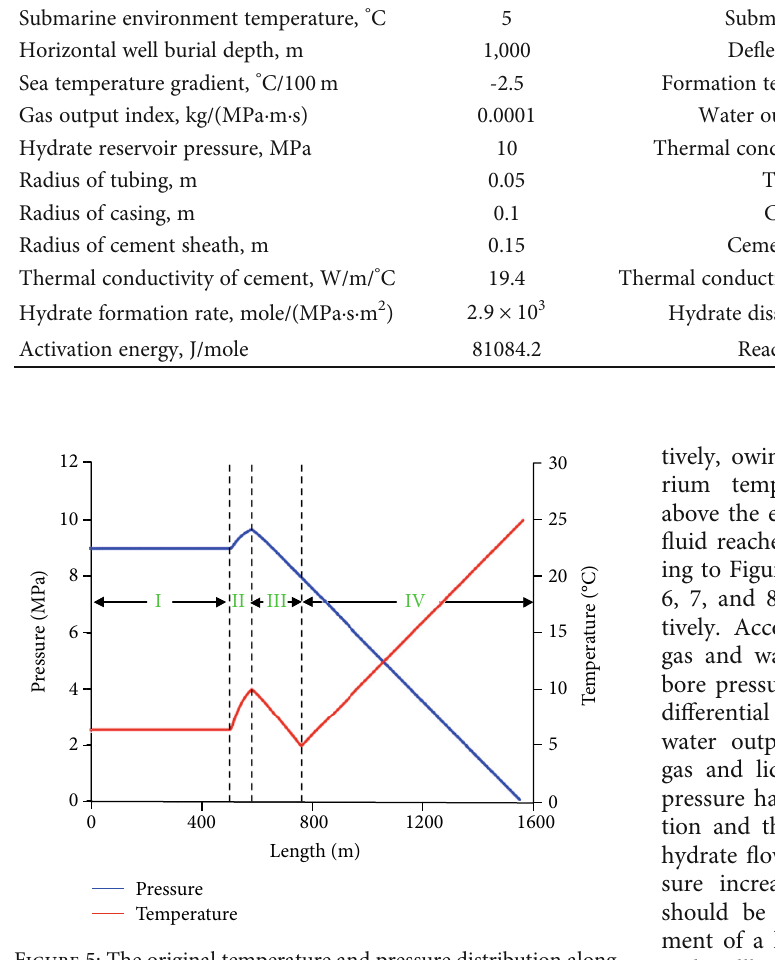
Figure 5: The original temperature and pressure distribution along with